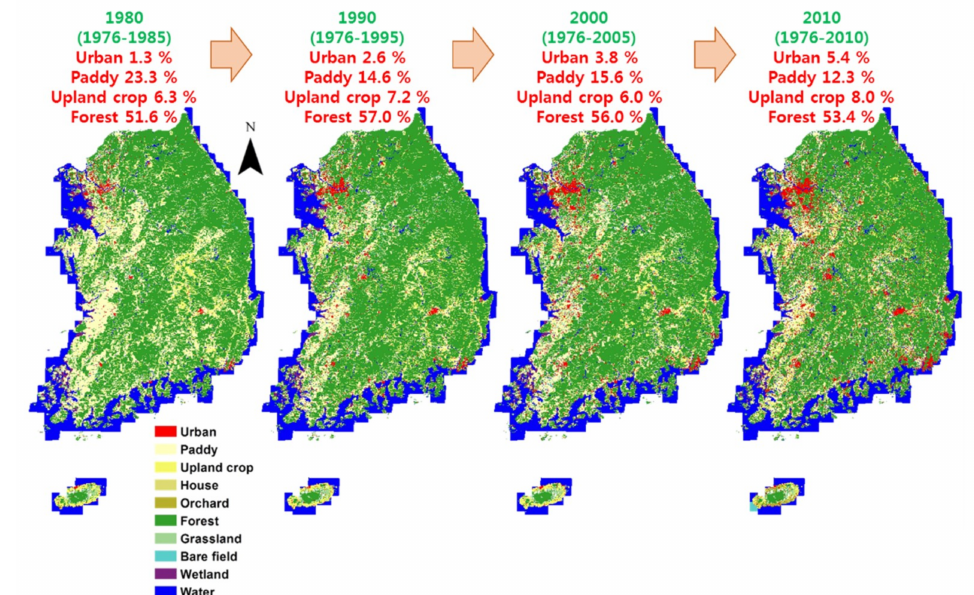
Figure A4. Distribution map of land uses (LUs) from 1976 to 2015 in the study